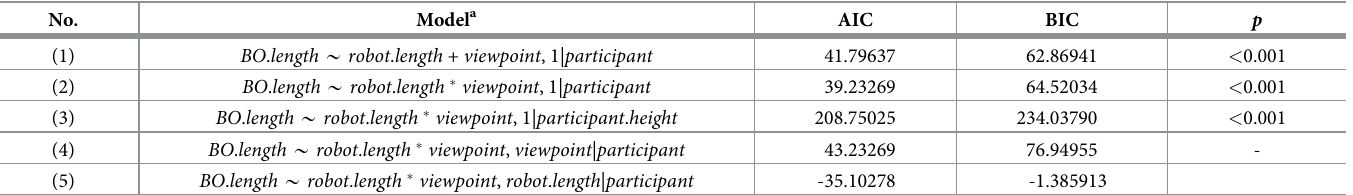
Table 2. Model selection for back-off length using information criteria AIC, BIC, and p-value between model (5) and the models (1)–(4). No.